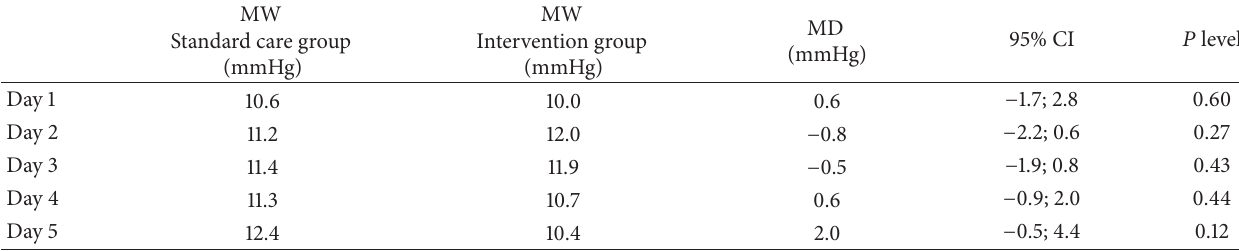
Table 3: Mean daily ICP